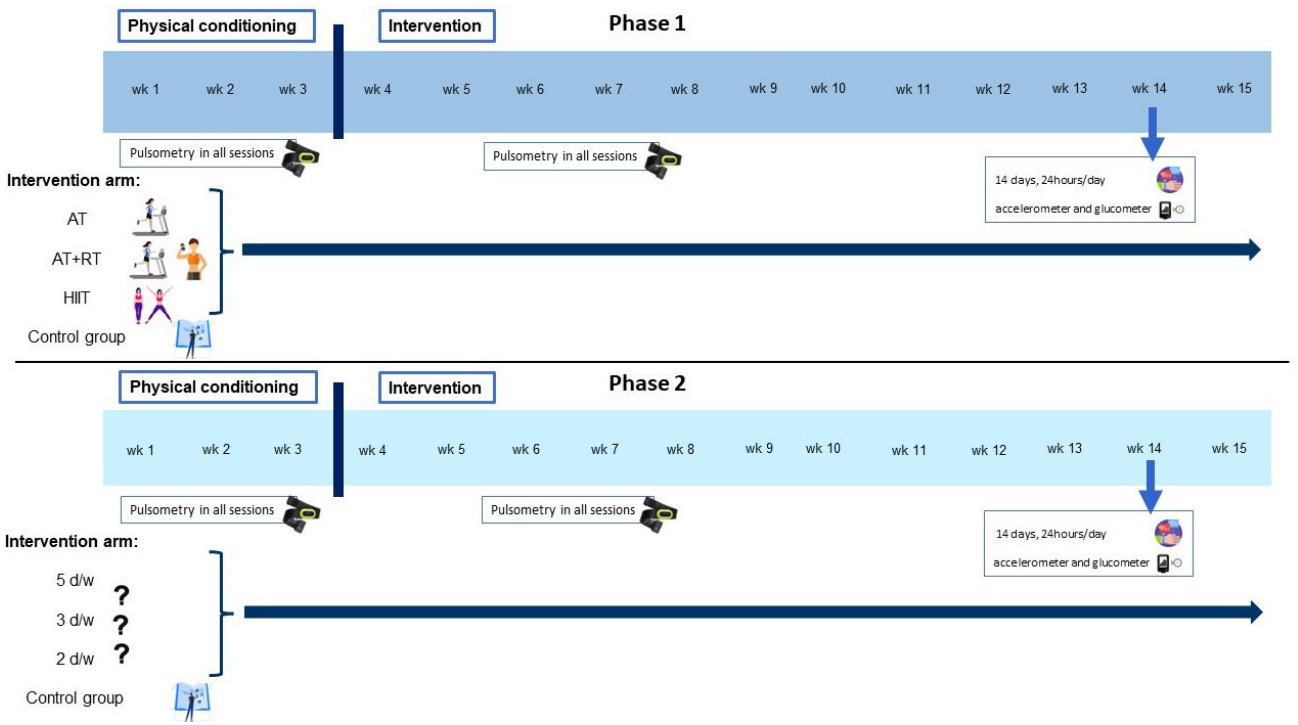
Figure 1. Intervention description. Abbreviations: AT, aerobic training; RT, resistance training; HIIT, high-intensity interval training; d/w, days/week; wk, week. high-intensity interval training; d/w, days/week; wk,